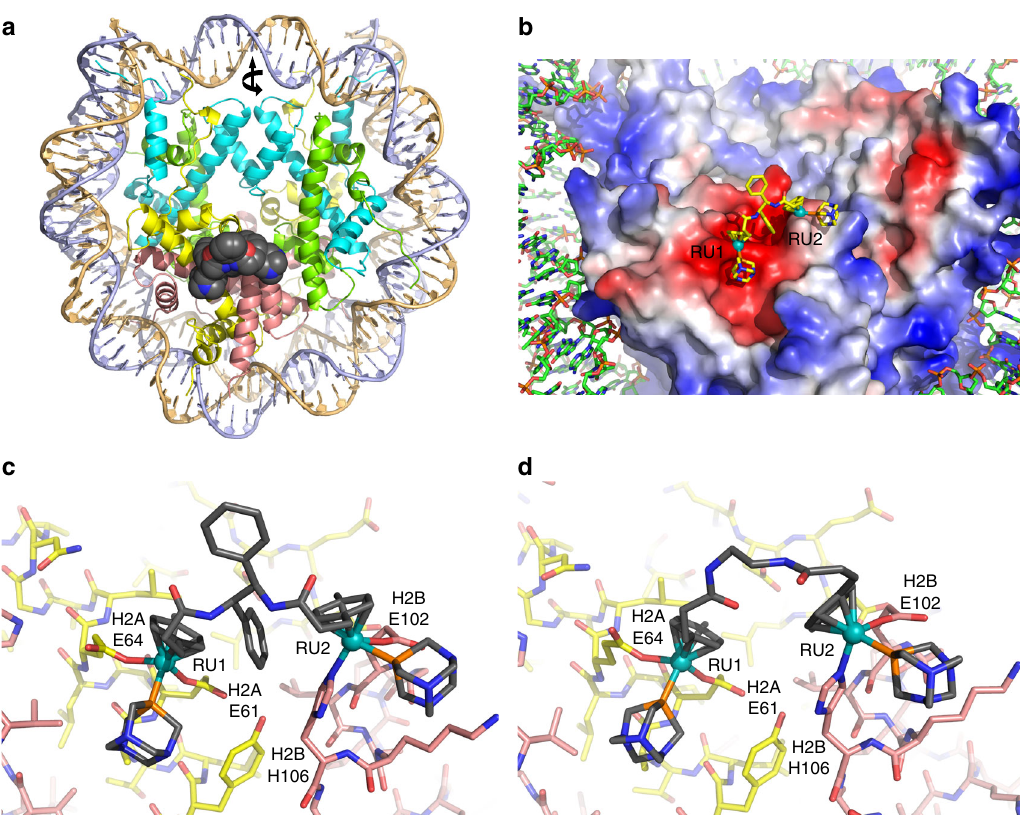
Fig. 2 X-ray crystal structures of binuclear-treated NCP. a Overview of NCP with an RR adduct (space fi lling representation) in the acidic patch. Histone proteins are coloured cyan (H3), green (H4), yellow (H2A) and salmon (H2B), and the two DNA strands are shown in different colours. Twofold axis of pseudo-symmetry is indicated (arrow). b View of one face of the nucleosome core with an RR adduct. The histone octamer is rendered with an electrostatic potential surface (red, negative; blue, positive) to emphasize the acidic patch. c , d Close up views of histone interactions with the RR ( c ) or the C2 ( d )